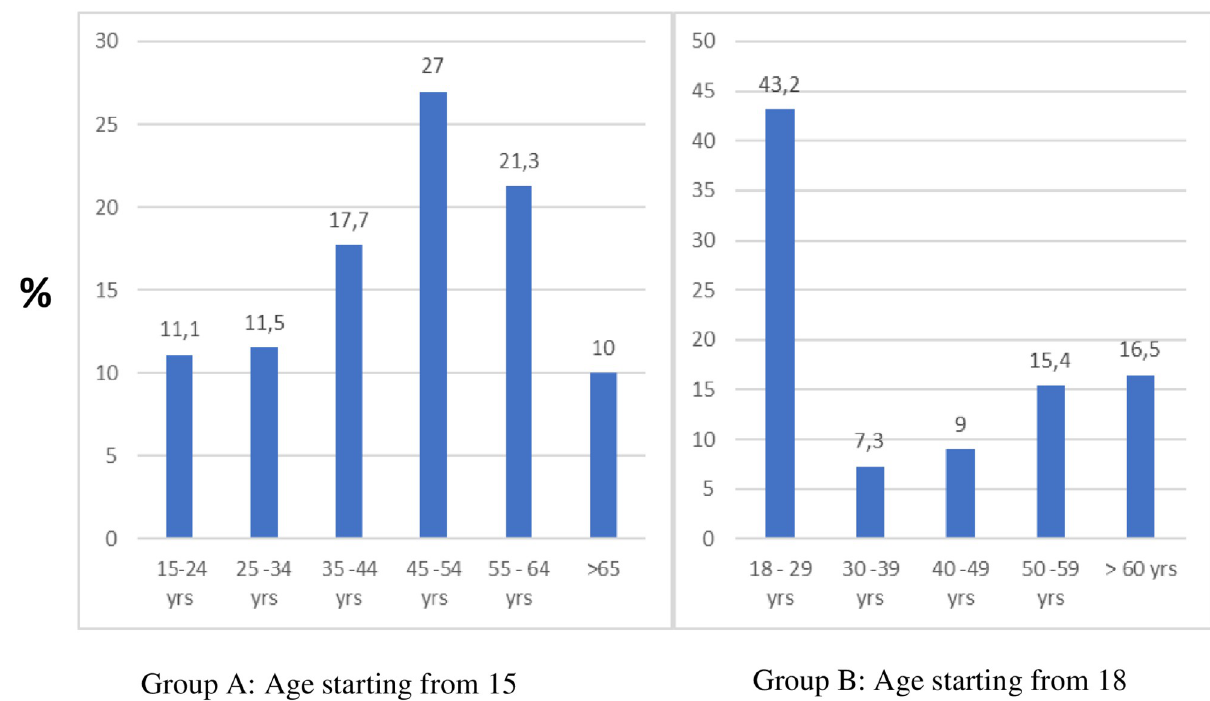
Fig 4. Presents the prevalence of pre-diabetes stratified by age. Except for the 18–29 age range in group B, the proportion of individuals with prediabetes tends to increase with increasing age.